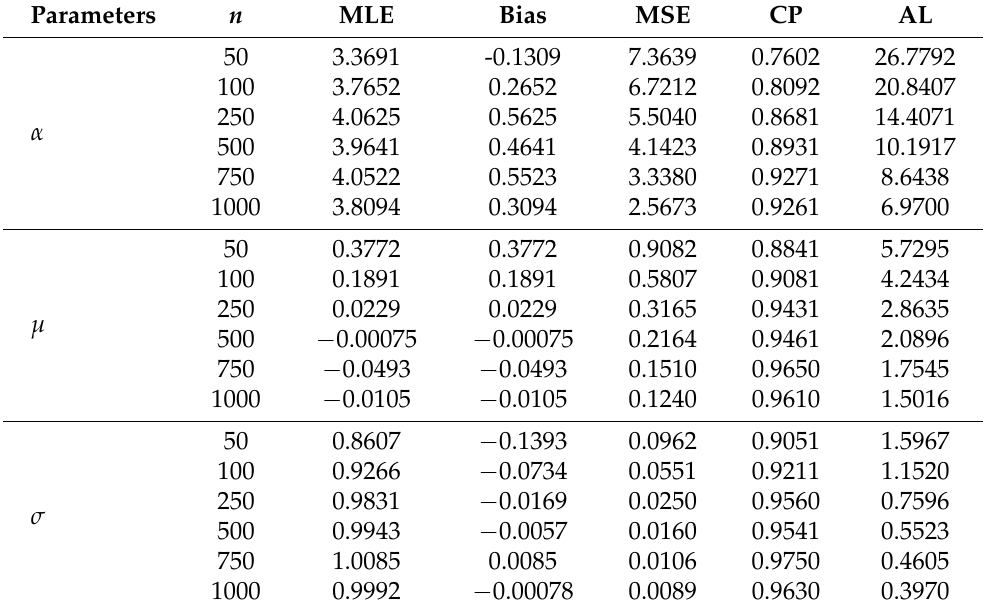
Table 3. The MLE simulation results for ( α = 3.5, µ = 0, σ = 1).